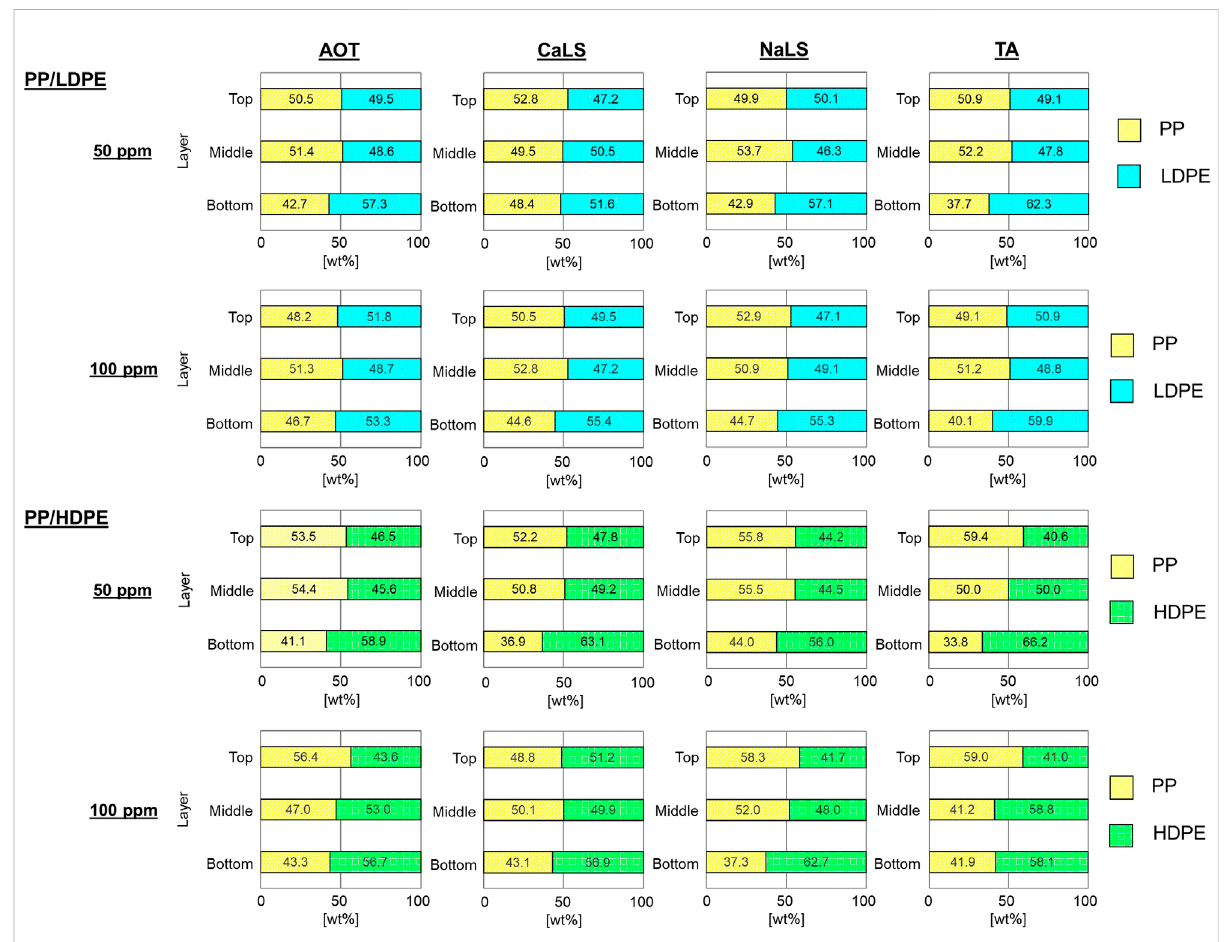
FIGURE 6 The proportion of plastics in each layer after reverse hybrid jig separation of PP/LDPE and PP/HDPE with continuous bubble generation at air fl ow rate of 1.0 L/min in the solution with AOT, CaLS, NaLS, and TA at concentration of 50 and 100